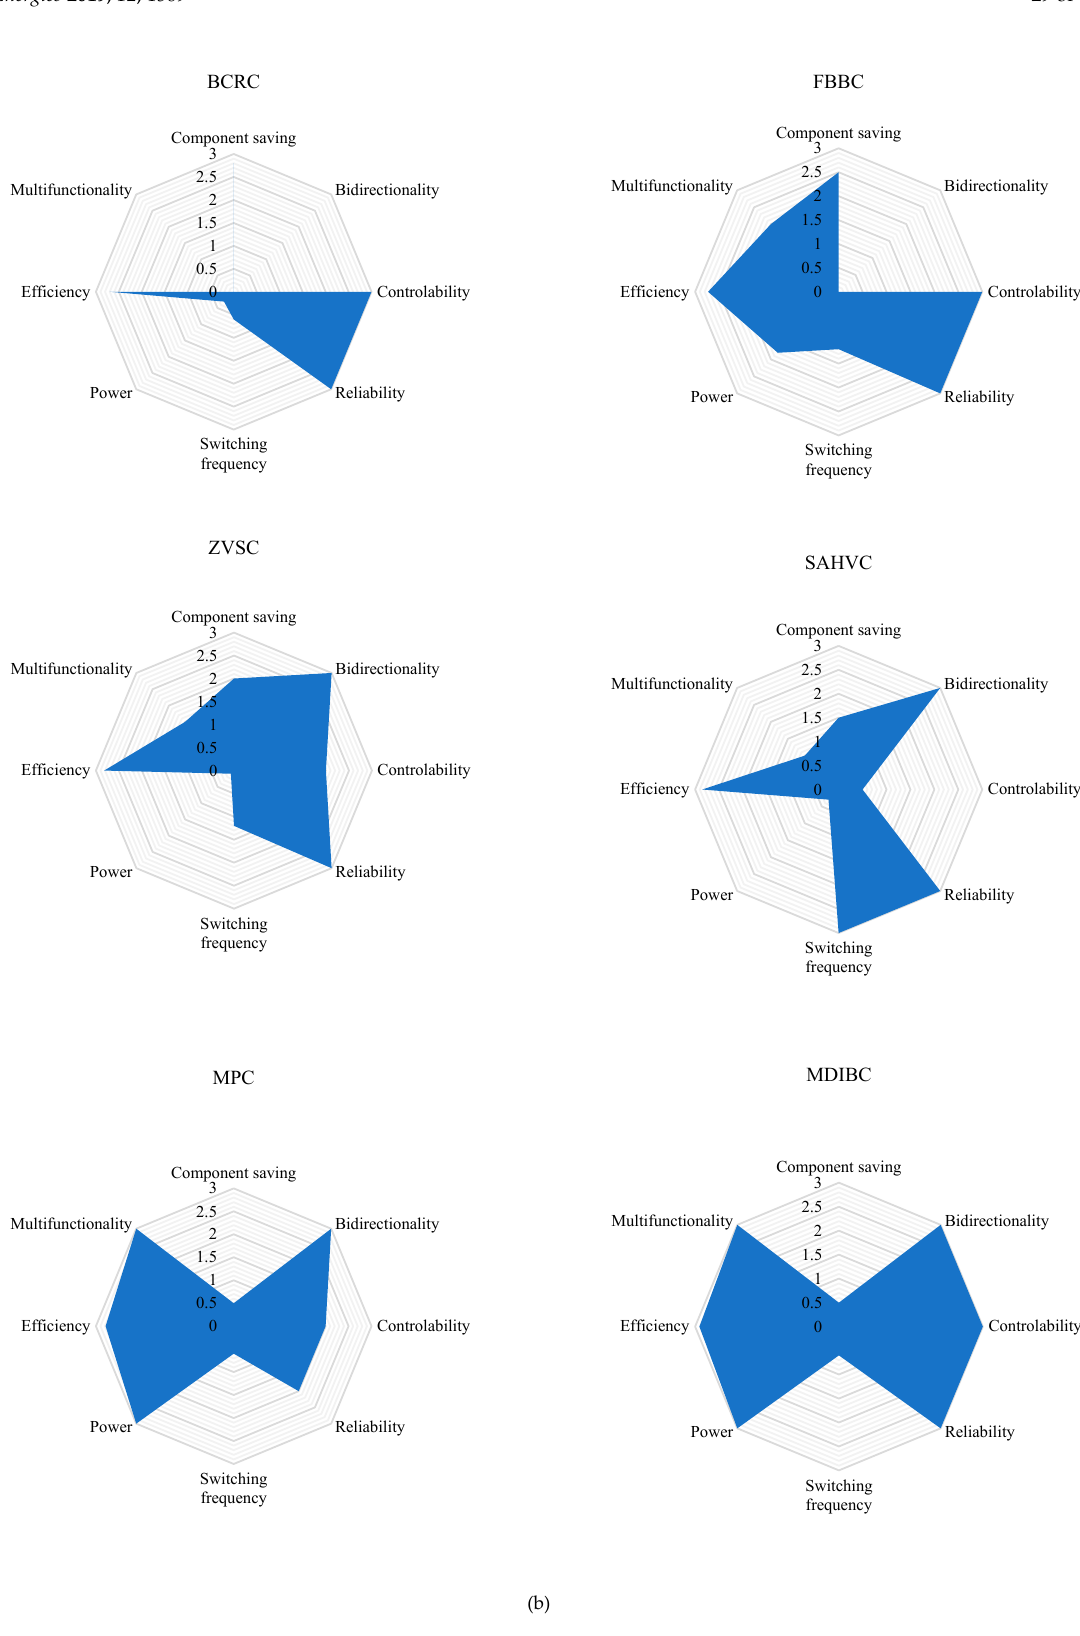
Figure 26. Comparison of DC-DC converter characteristics ( a ) all DC-DC converters in the same plot and ( b ) individual plot of DC-DC converter topologies, here numerical scale indicates normalized values using Equation